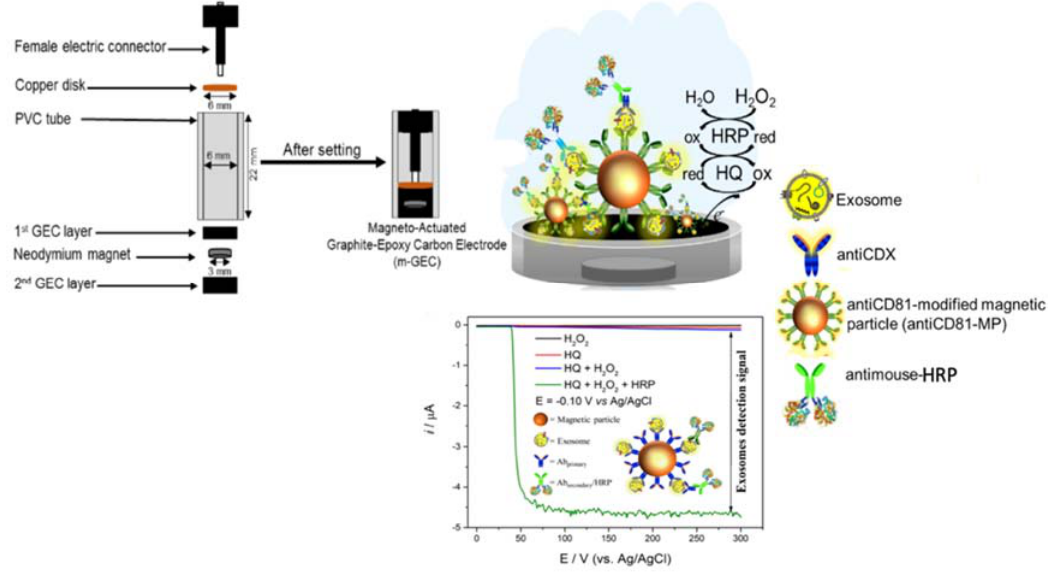
Figure 3. Schematic representation of the construction of the magneto-actuated electrode based on rigid composites (m-GEC) as well as the enzymatic reaction based on hydroquinone mediator.